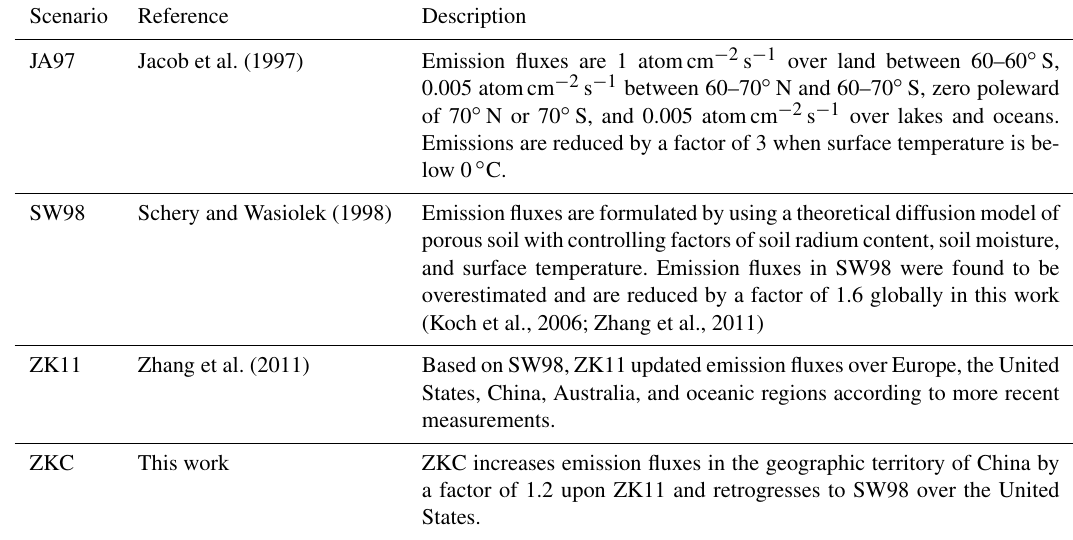
Table 1. Global 222 Rn emission scenarios used in this